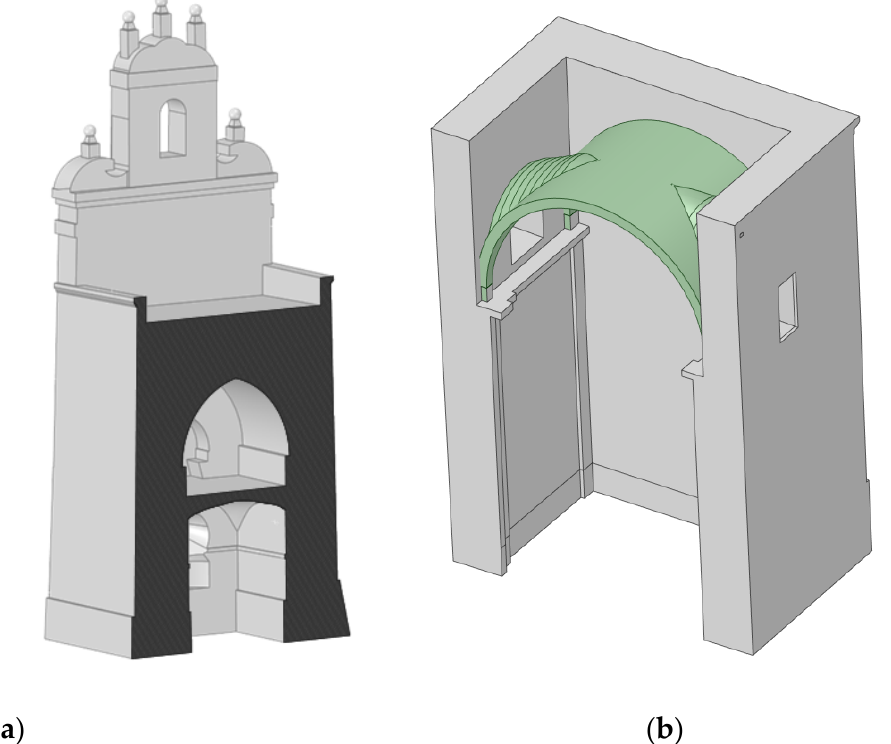
Figure 9. Results obtained during the modelling of different vaults: ( a ) the vaults of the tower located at the baptistery and ( b ) example of the modelling of one lunette vault at the apse of the church (the infill was not visible for clarity purposes).